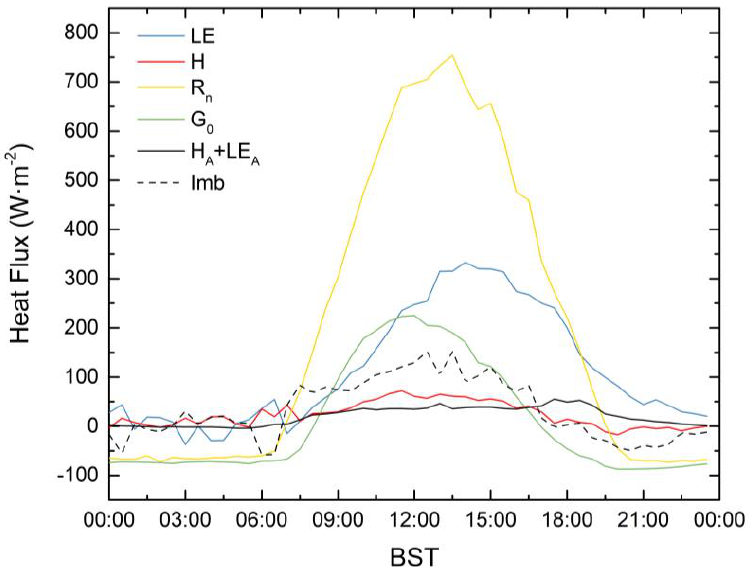
Figure 8. A diurnal ensemble average over 15 days for each component of the surface energy budget in FOF from 11 July to 25 July (blue line: latent heat flux ( LE ); red line: sensible heat ( H ); yellow line: net radiation ( R n ); green line: soil heat flux ( G 0 ); black line: horizontal thermal advection ( H A + LE A ); black dash line: imbalance energy on surface energy exchange.).